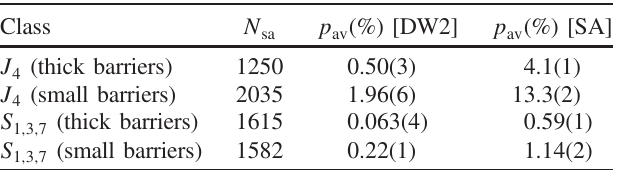
TABLE III. Raw results of the experiments on the DW2 device and the SA codes for additional instance classes we study. Listed are average success probabilities ( p ) in percent, as well as the av number of disorder instances N sa